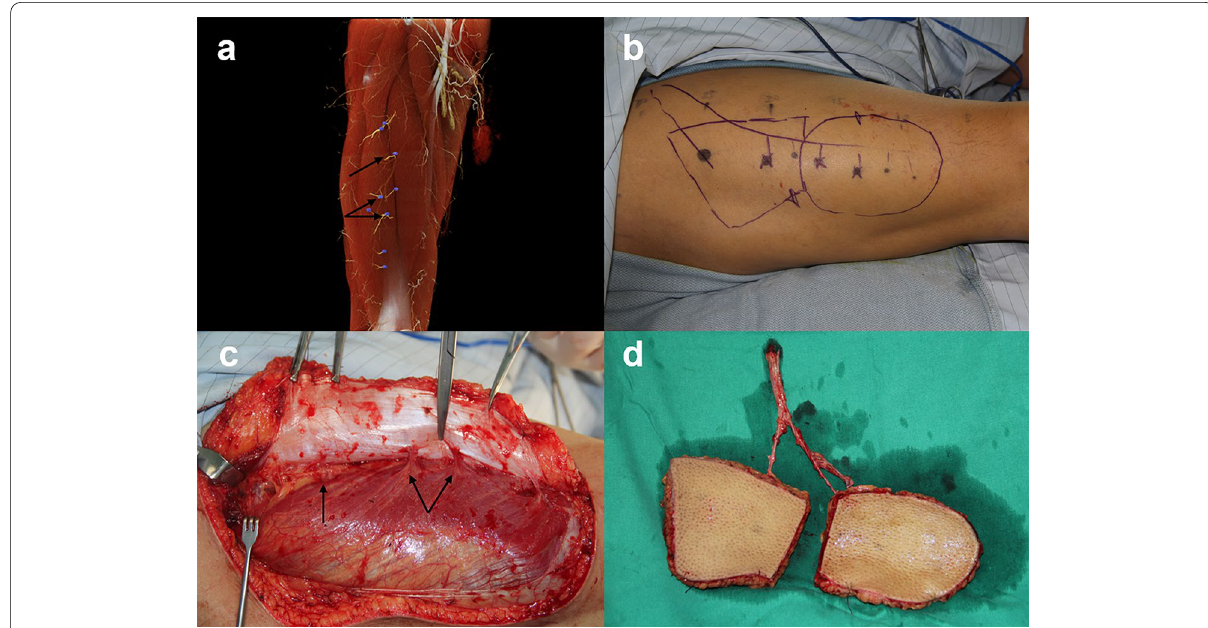
Fig. 5 A case example of lobed flap harvesting guided by preoperative CTA mapping. a–b CTA mapping showed the location of perforators and guided the design of a lobed flap. c–d Perforators observed during the operation were consistent with the preoperative CTA assessment, and the lobed flap was successfully